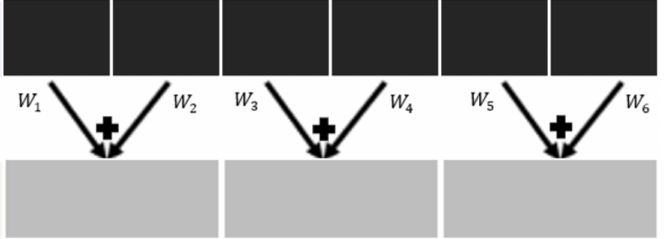
Figure 2. Linear combinations of two adjacent bands without any overlap for the RIT-18